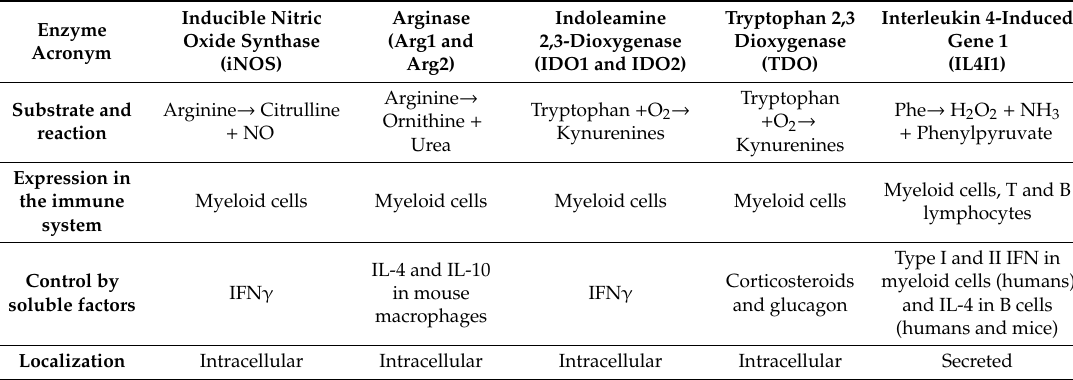
Table 1. Characteristics of the best-known amino-acid-catabolizing